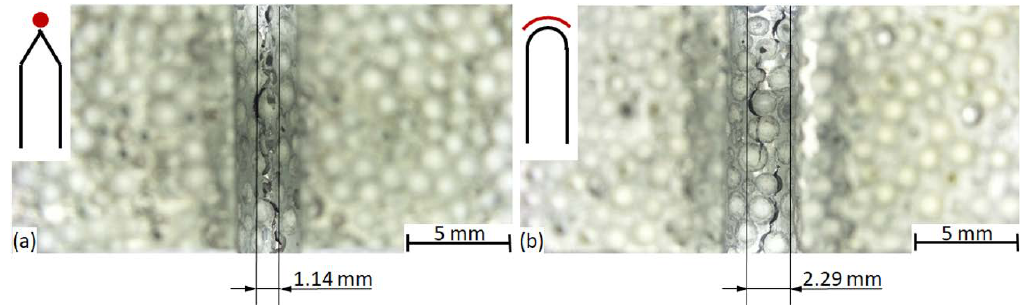
Figure 8. Initialized crack in the ( a ) AlSi12-V-3 and ( b ) Al99.5-U-3